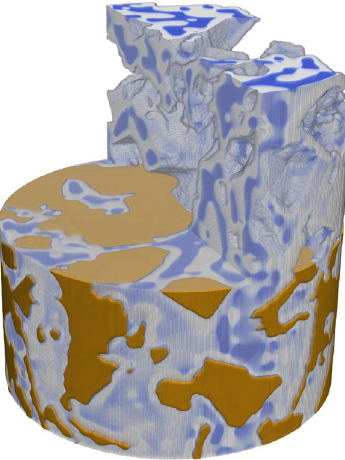
Figure 2. 3D visualisation of the simulation. The rock matrix have been removed from the upper part of the simulation along with upper front part of the fluid phase. The rock is brown, the water is blue and the oil is light grey. This figure is created with ParaView 47